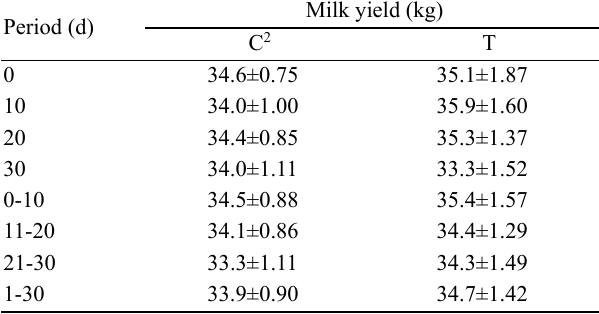
Table 3. Effect of dietary phytoncide on milk yield in dairy cows